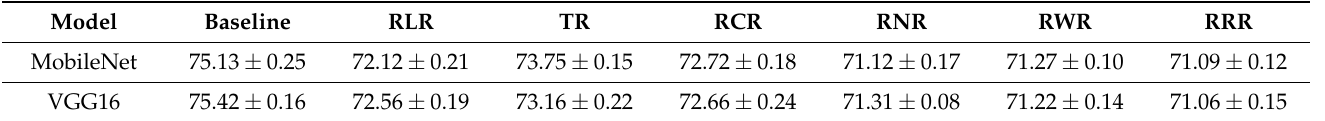
Table 6. Segmentation accuracy comparison between different data augmentation techniques (i.e., TR, RCR, RLR, RNR, RWR and RRR). MobileNet-based and VGG16-based autoencoders were applied on the Supervisely Person dataset. The results indicated that using rotation solely to augment data might not be a good for the segmentation task in this case.